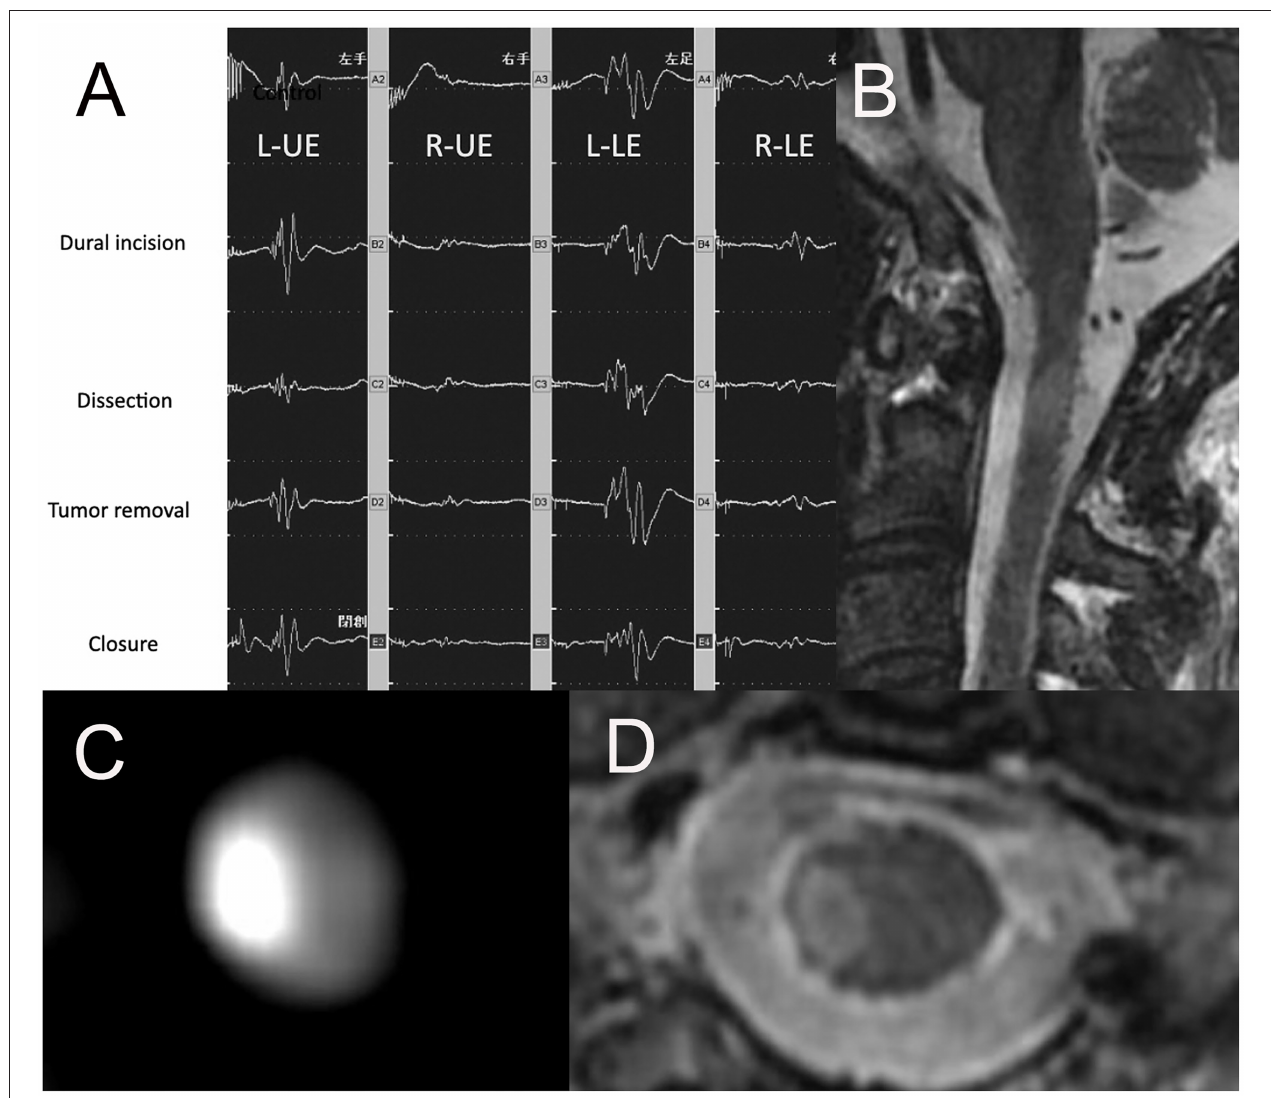
FIGURE 4 | (A) Ratio motor-evoked potential (MEP) of right UE and right LE suddenly reached down to 0 and 30% compared to the initial value, (B) the sagittal image of postoperative T1WI of MRI, (C) the axial image of postoperative DWI of MRI, (D) the axial image of postoperative FLAIR of MRI. UE, upper extremity; LE, lower extremity; TIWI, T1-weighted image; MRI, magnetic resonance imaging; T2WI, T2-weighted image; DWI, diffusion-weighted imaging; FLAIR, fluid-attenuated inversion